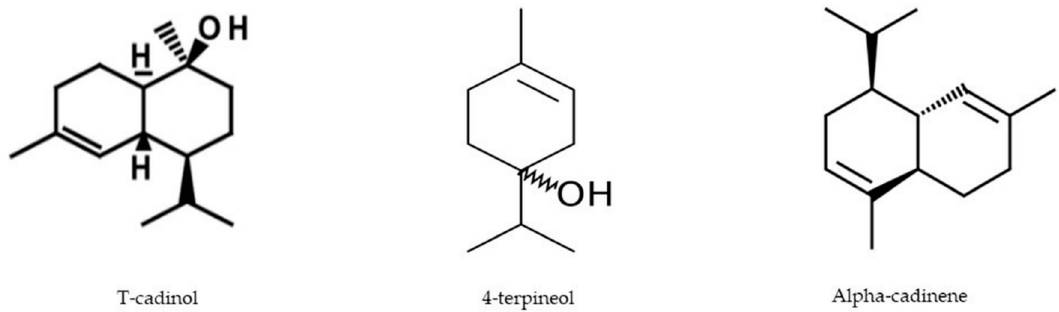
Figure 10. Chemical structures of major compounds identified based on computational study.